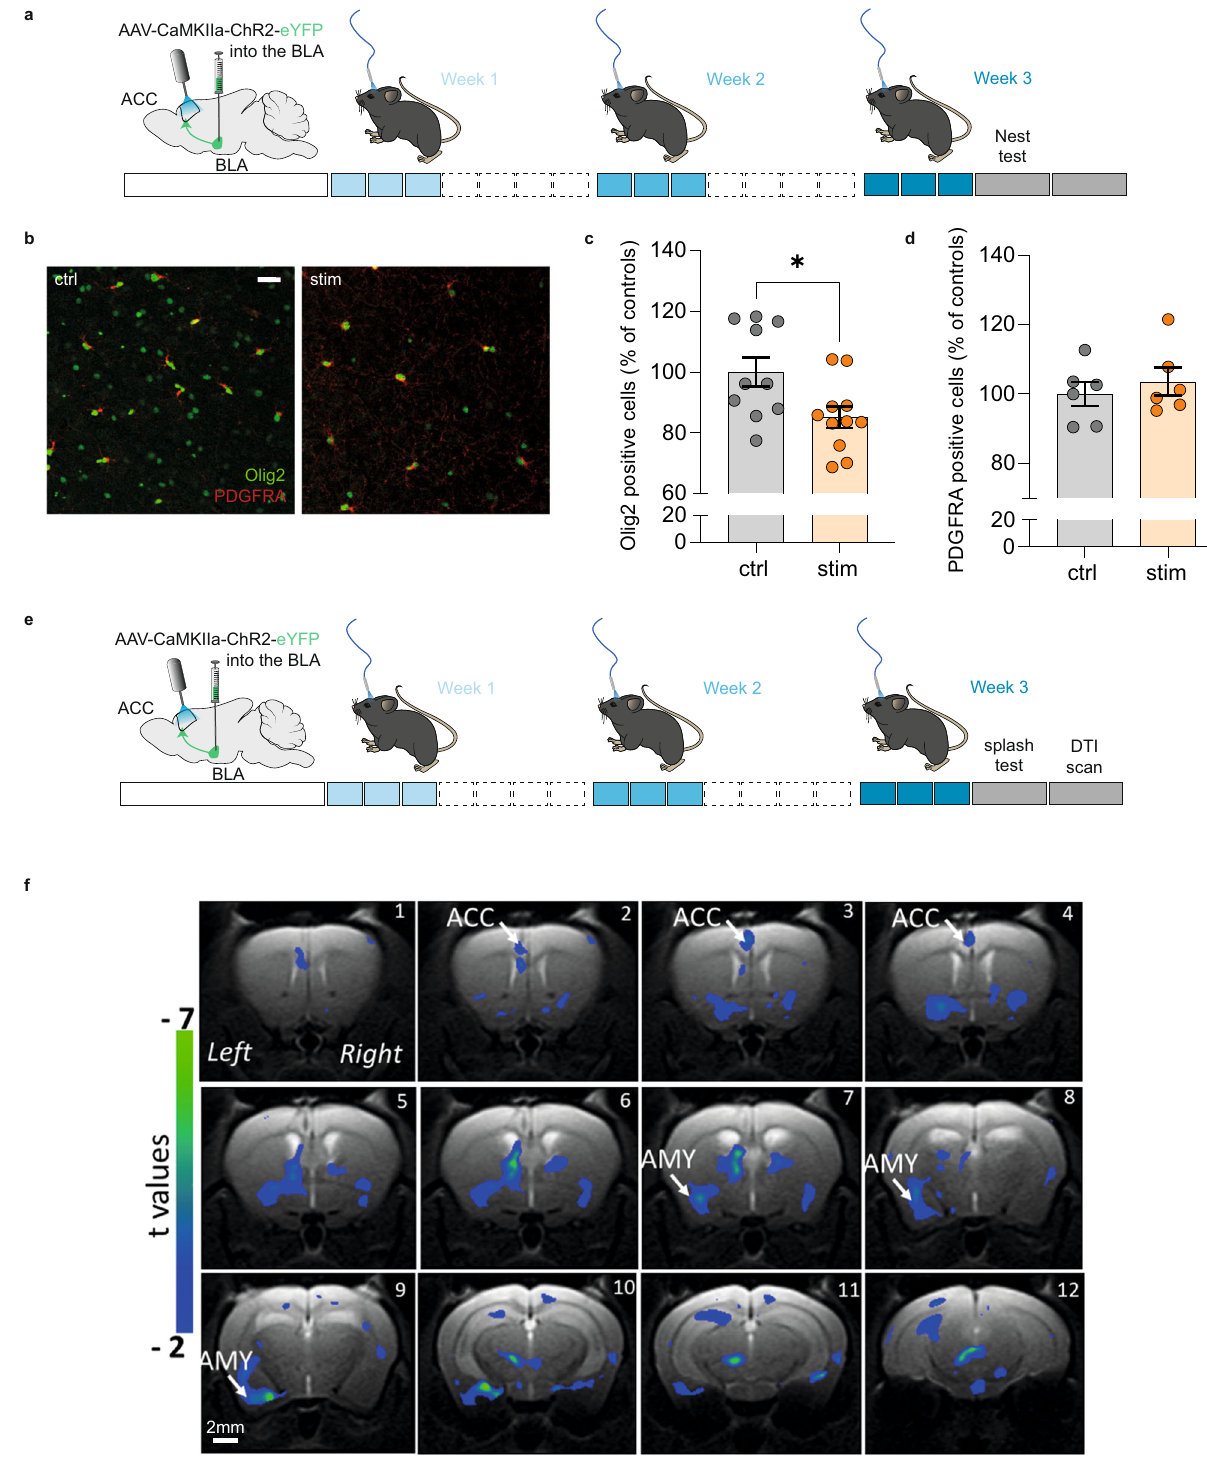
Fig. 7 | Repeated activation of the BLA – ACC pathway impairs myelination. a Graphicalrepresentationoftheexperimentaldesign,includingvirusdeliveryinto the BLA, cannula implantation into the ACC and the nine sessions of optogenetic activation. b Representative fl uorescence images showing cells that are Olig2+ (green)orPDGFRA+(red)innon-stimulated(leftpanel)andstimulatedmice(right panel). Scale bar=50 µ m. c , d Quanti fi cation of Olig2 and PDGFRA-positive cells showedthatnineoptogeneticstimulationsoftheBLA – ACCpathwaydecreasedthe numberofOlig2+cellswithoutaffectingthenumberofPDGFRA+cells( e :ctrl: n =6 mice;99.97±3.45;stim: n =6mice;103.6±4.00; P =0.41)intheACC( d :ctrl: n =10